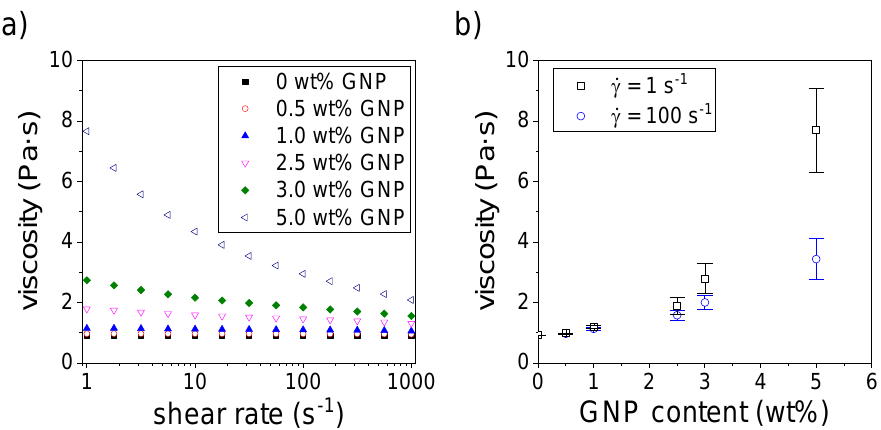
Figure 1. ( a ) Characteristic curve showing shear rate dependency of viscosity for nanocomposite precursors containing di ff erent amounts of graphite nanoplatelets (GNPs); ( b ) average viscosity